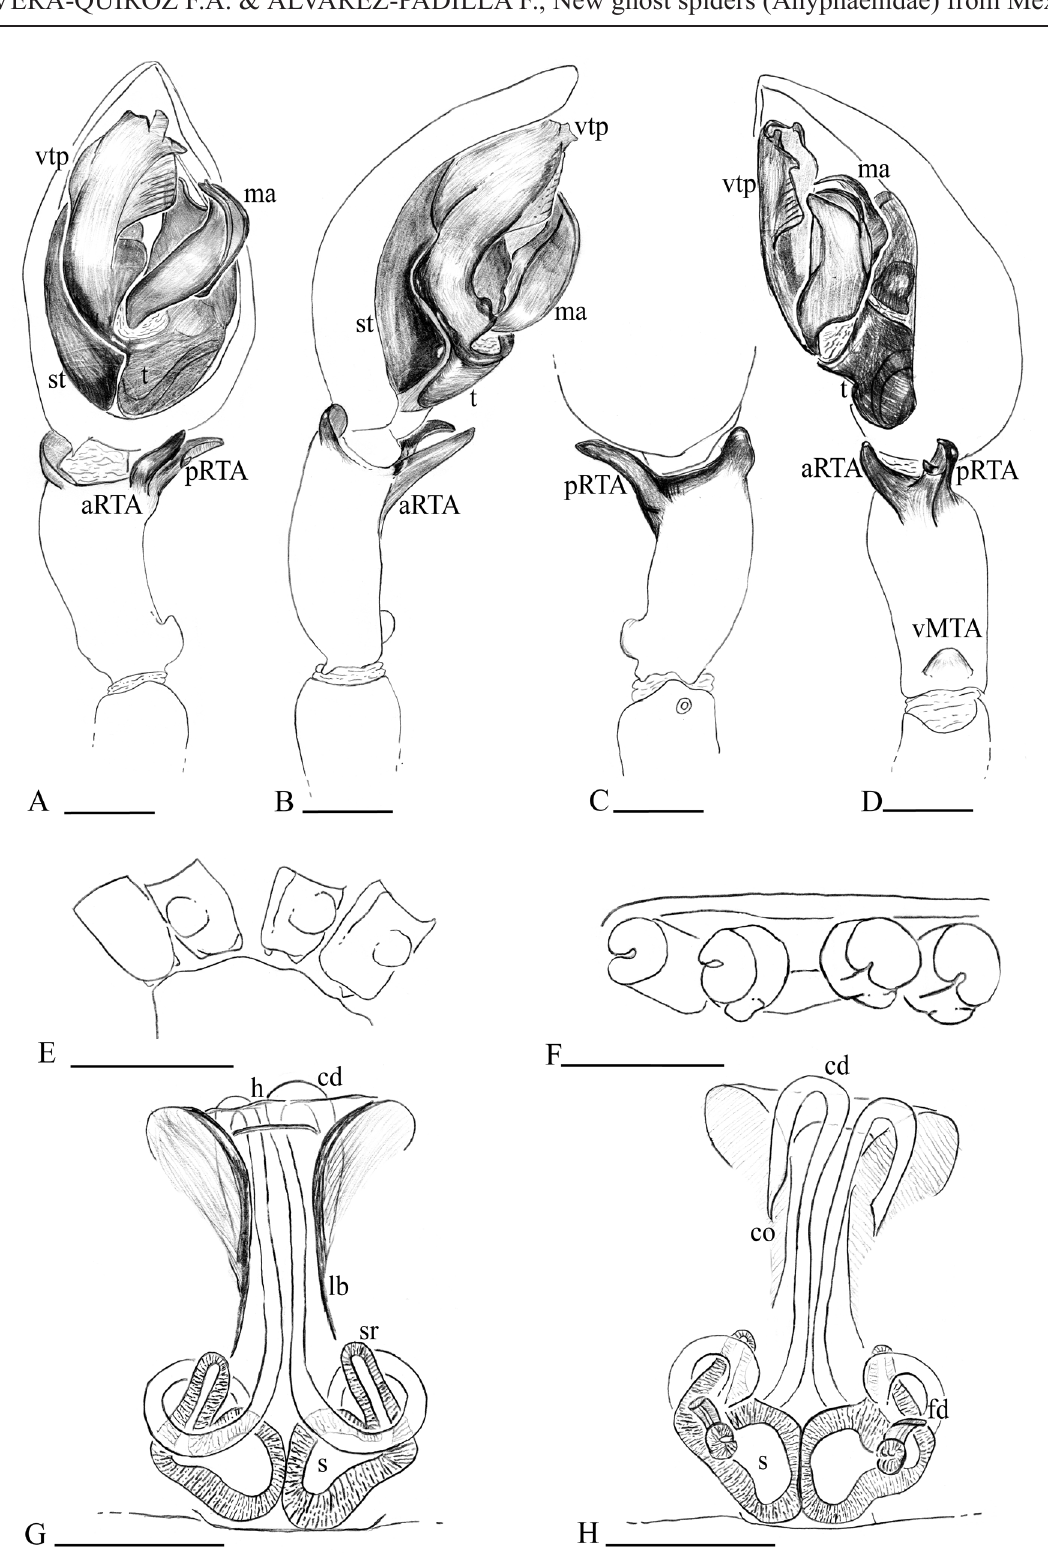
Fig. 41. Anyphaena porta sp. nov. A–F . Paratype, ♂ (CNAN-T01563). G–H . Paratype, ♀ (CNAN-T01565). A . Pedipalp, ventral view. B . Pedipalp, prolateral view. C . Pedipalp, dorsal view. D . Pedipalp, retrolateral view. E . Coxae, ventral view. F . Coxae, lateral view. G . Epigynum, ventral view. H . Epigynum, dorsal view. Scale bars: A–D, G–H = 0.2 mm; E–F = 1.0